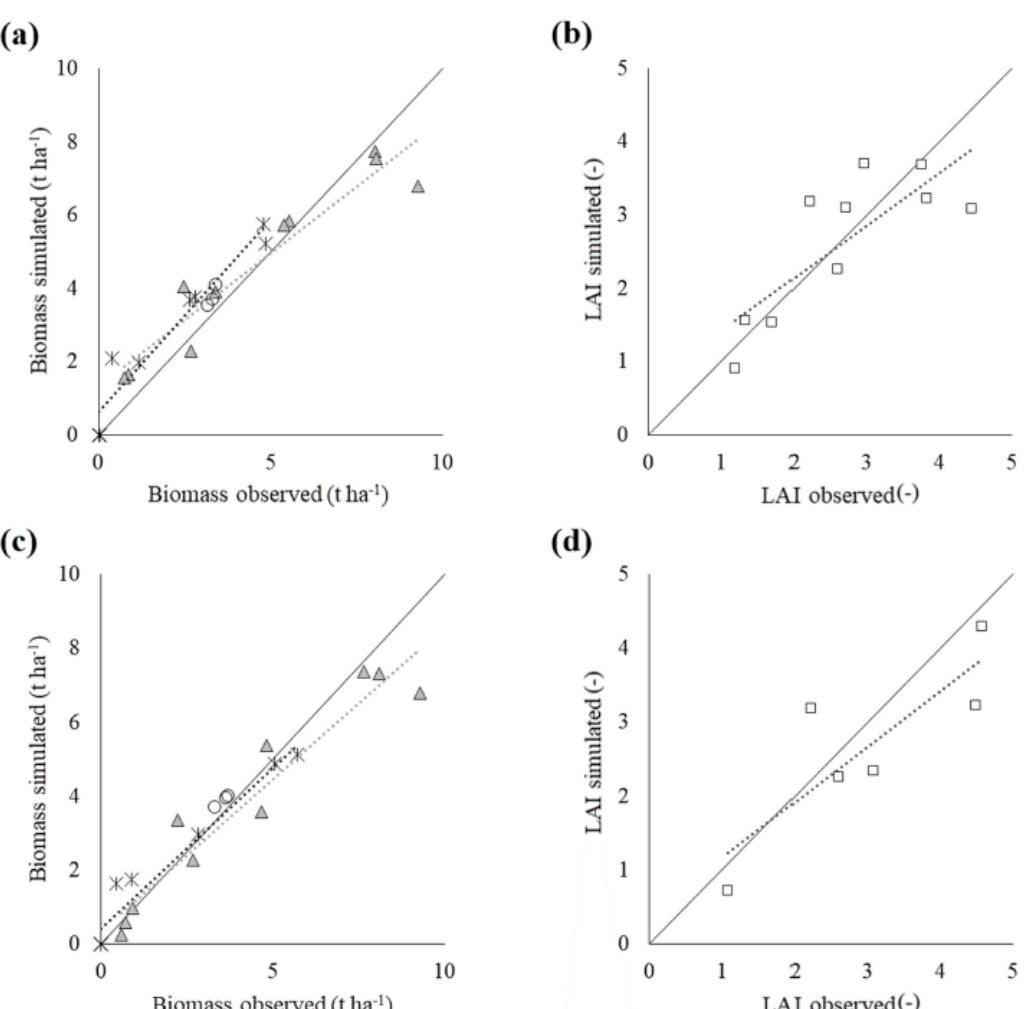
Figure 3. Agreement between observed and simulated data for the calibration ( a , b ) and validation ( c , d ) datasets. Biomass refers to dry aboveground biomass (triangles), pod biomass (stars), and grain yield (circles). LAI: leaf area index. The solid line represents perfect agreement (1:1 line).